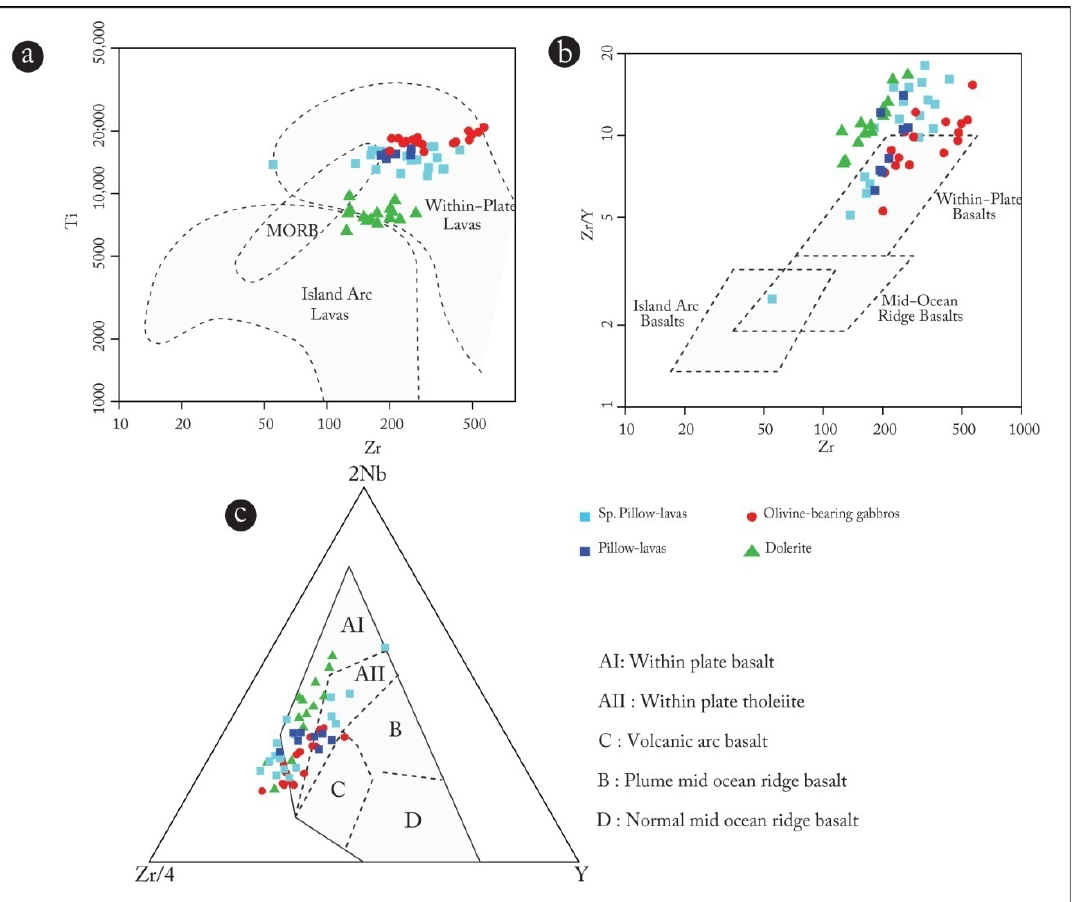
Figure 26. Zr-Ti[72] ( a ), Zr-Zr/Y [71] ( b ) and Zr/4-2Nb-Y [73] ( c ) diagrams. Figure 26. Zr-Ti [71] ( a ), Zr-Zr/Y [70] ( b ) and Zr/4-2Nb-Y [72] ( c )